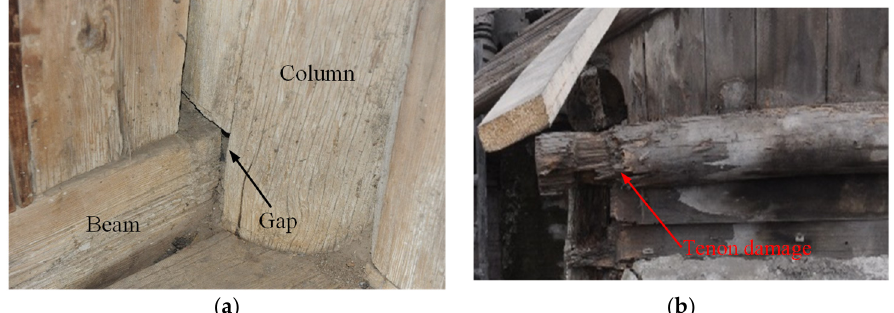
Figure 3. Damages of the mortise-tenon joint: ( a ) Gap between the mortise and tenon; ( b ) bamage in the tenon.